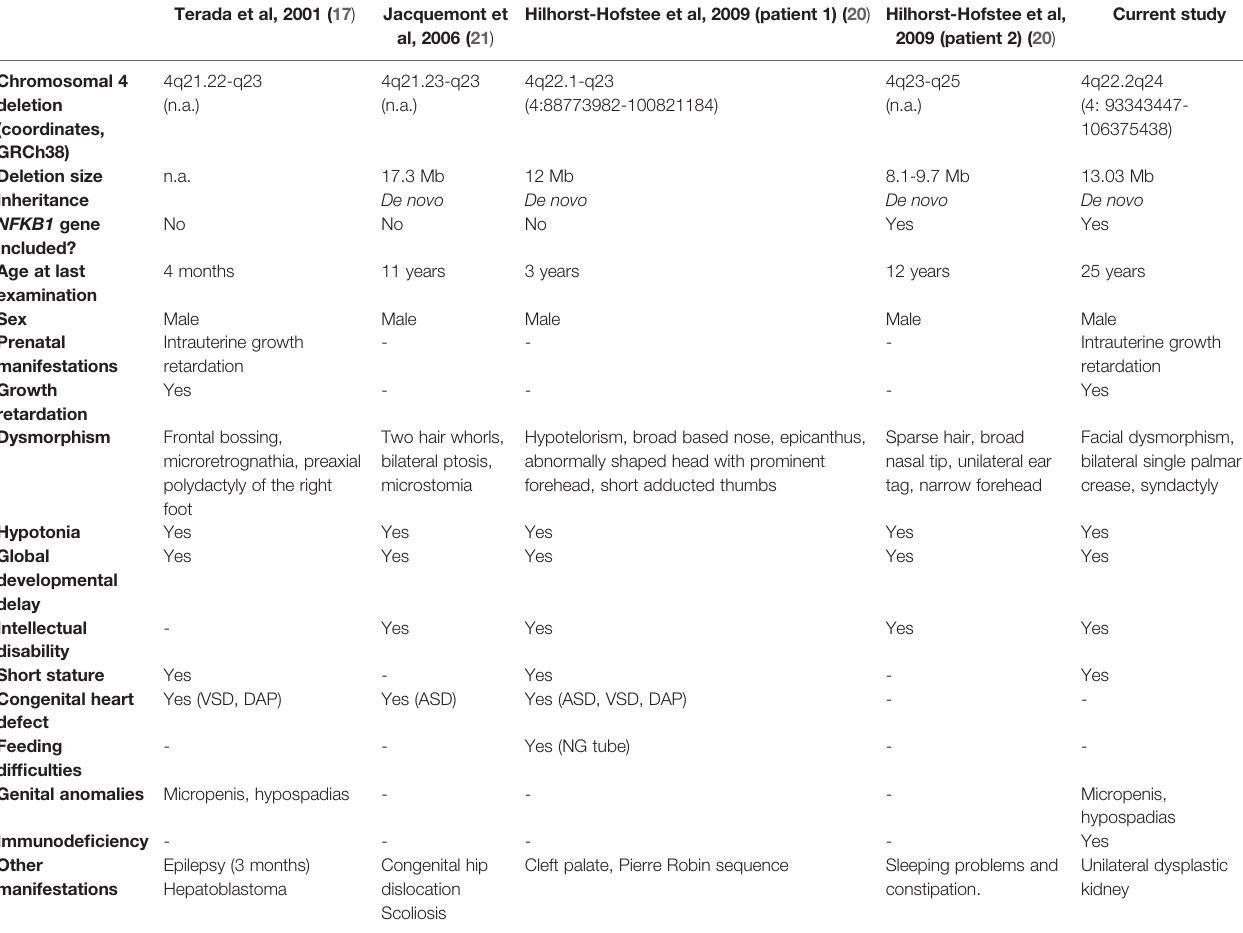
TABLE 2 | Clinical and molecular features of reported patients with chromosomal deletions overlapping the 4q22.2-q24